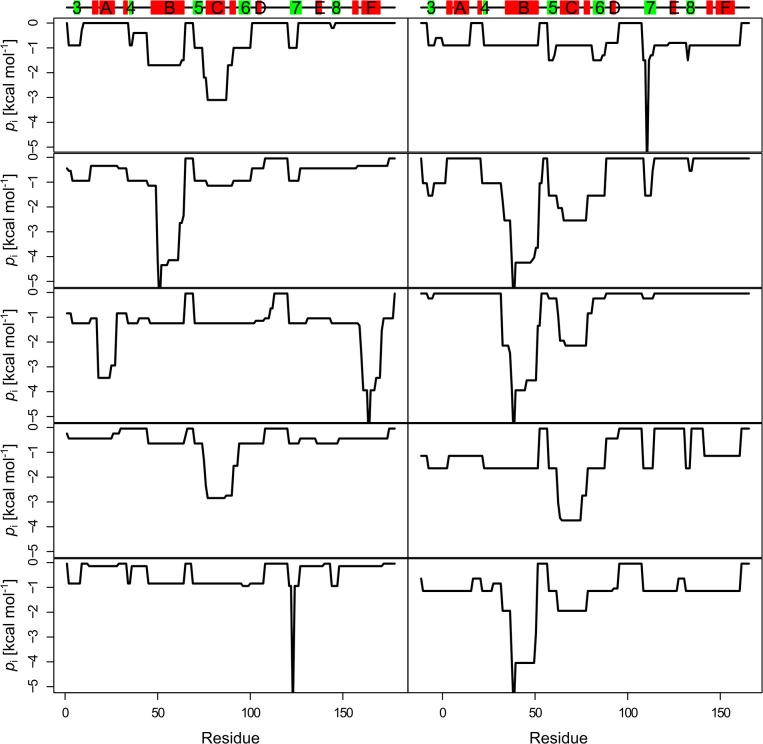
Residue-wise p
i plots for medoids of the 10 clusters.Secondary structure elements as computed by the DSSP program [88, 89] are indicated on the top of the plots and are labeled: α-helix (red rectangle), β-strands (green rectangle), loop (black line).